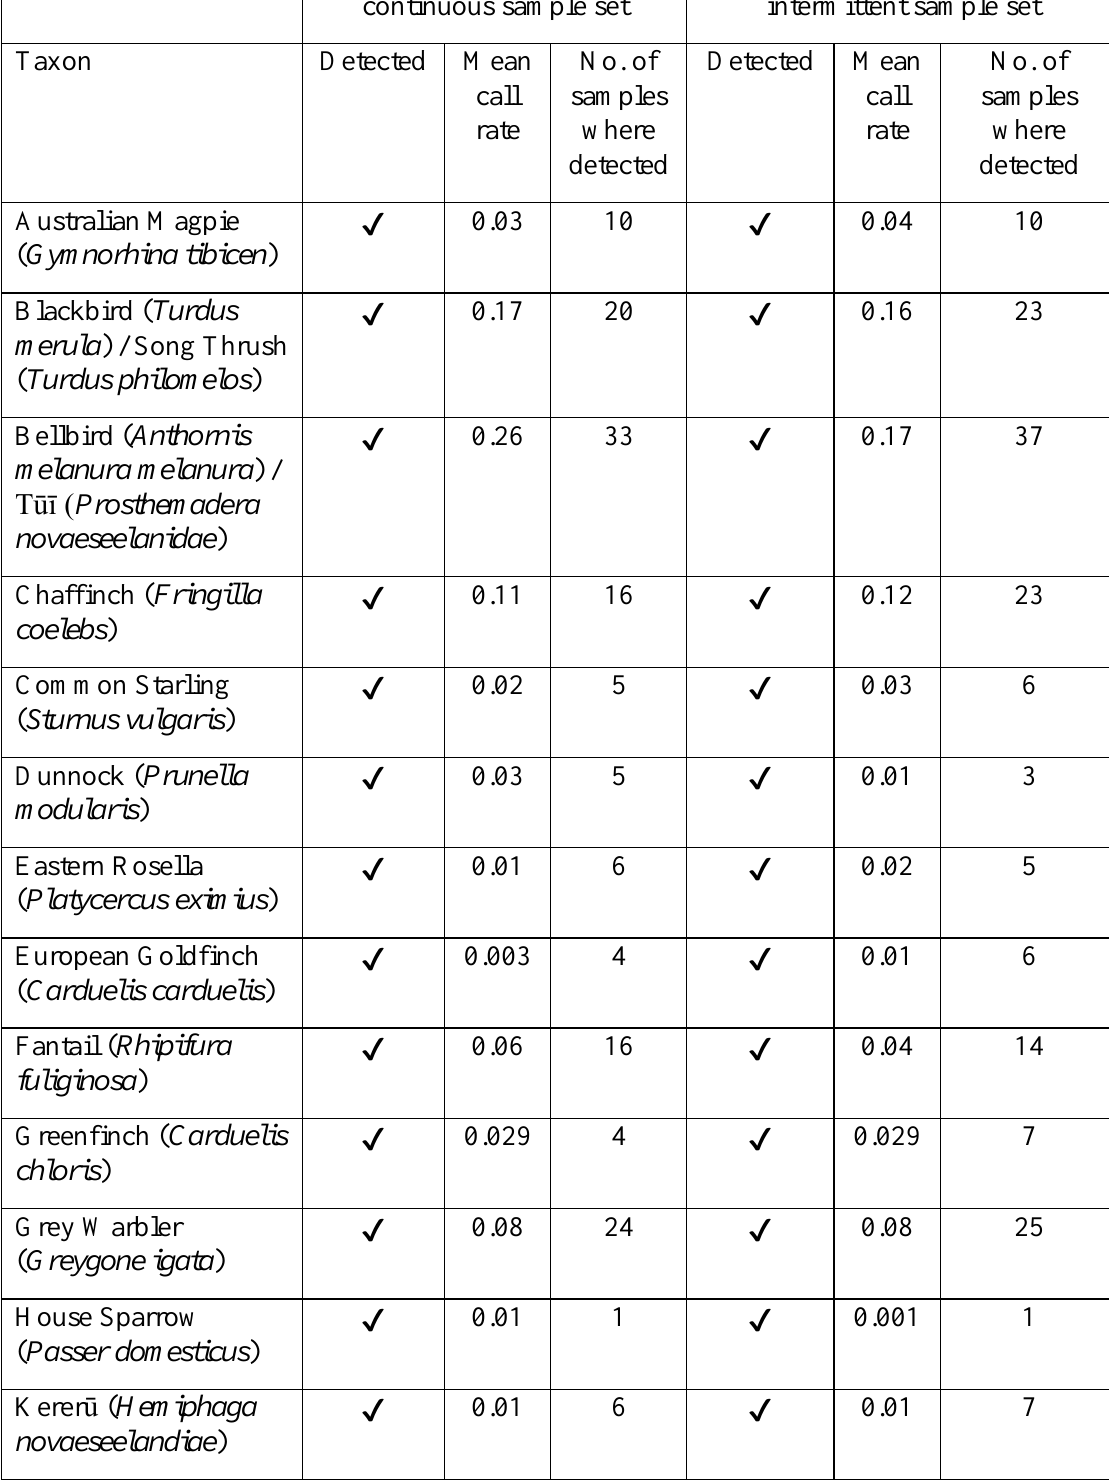
Table A1.1. List of the species detected from the 50 continuous and intermittent